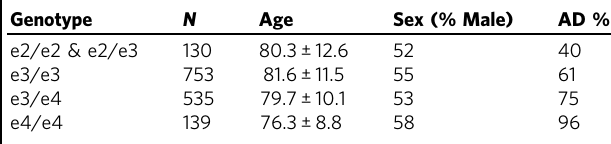
Table 5 Demographic of the NACC v 10 sample. Table 3 FTLD/tauopathy results by Chi square for APOE